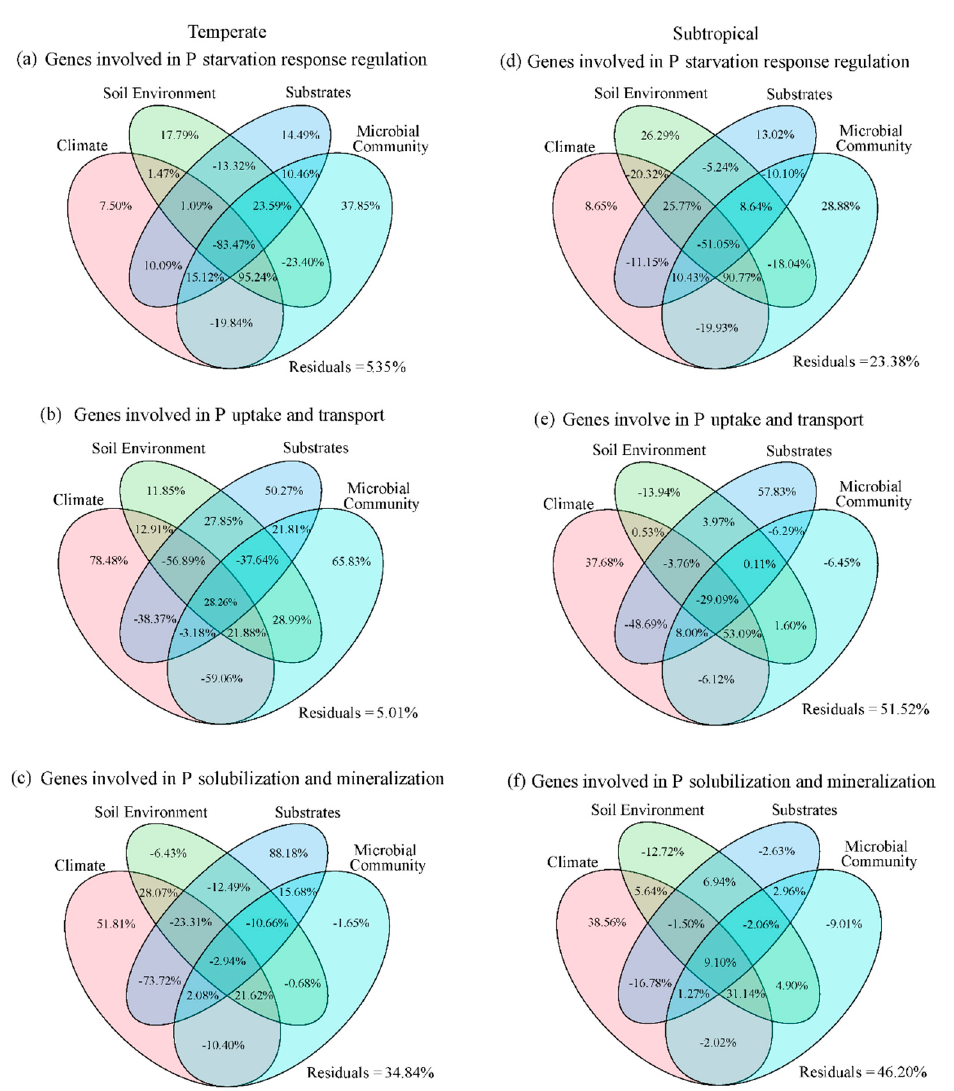
Figure 5. Relative contributions of climate, soil substrates, soil environment, and microbial community to the abundance of phosphorus functional genes in temperate and subtropical forest biomes. Variation partitioning analysis was conducted to identify the variance in the abundance of phosphorus functional genes by these four groups of biotic and abiotic factors. Ellipses represent the different groups of factors (climate, soil substrates, soil environment, and microbial community). Numbers represents the variation partitioned by different sections.